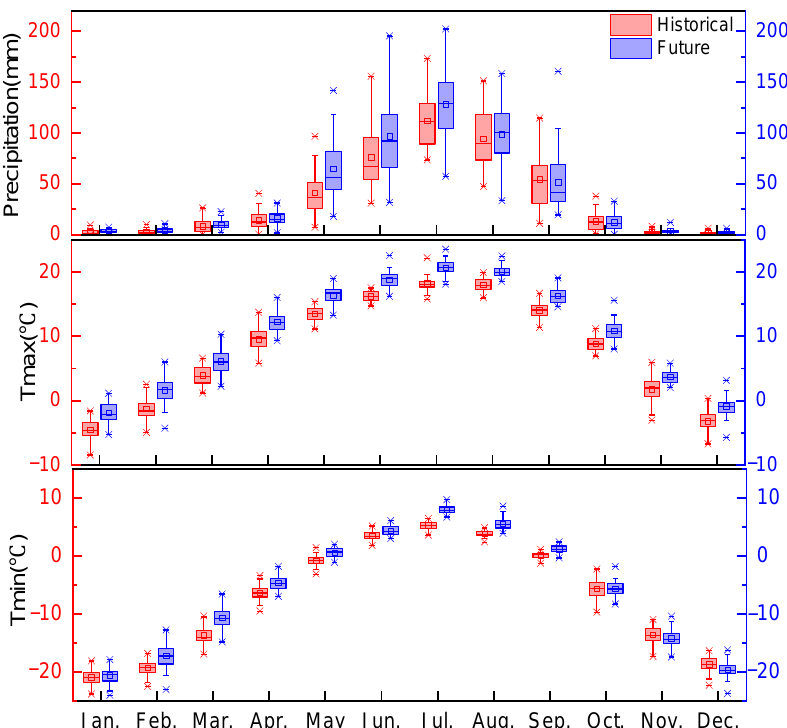
Figure 6. Boxplot of inter-annual temperatures and precipitation in the historical and future periods in the study area.